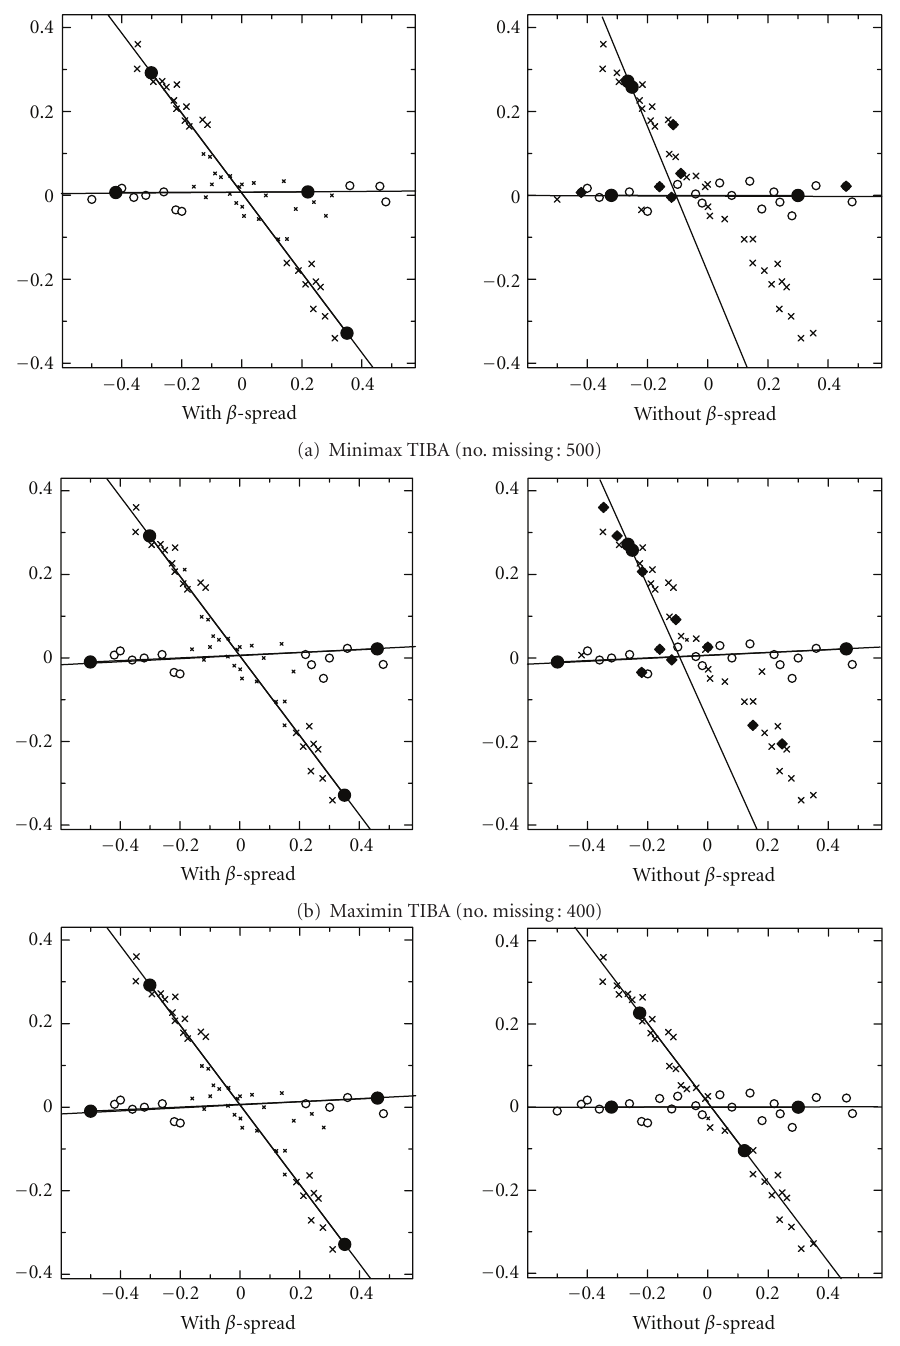
Figure 2: Comparison of cluster partitions from relational data imputed by three TIBAs, with (left)/without (right) β -spread transformation (Euclidean